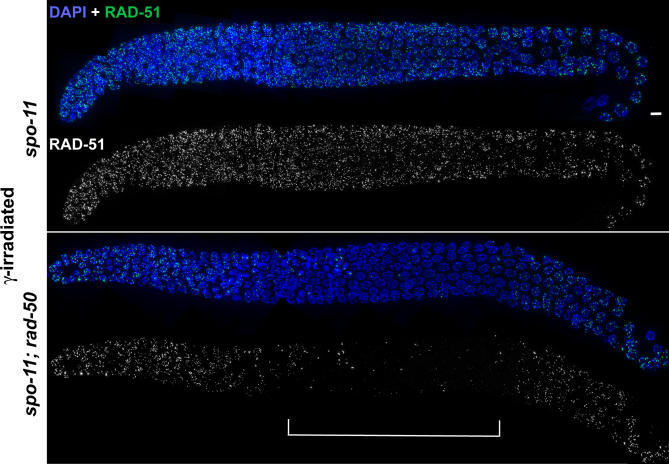
Context-Specific Requirement for Rapid Accumulation of RAD-51 at Sites of IR-Induced BreaksGerm lines from spo-11(ok79) and spo-11(ok79); rad-50 hermaphrodites fixed 1 h after exposure to 1 krad γ-irradiation and stained with DAPI and RAD-51 antibody. RAD-51 foci are detected in germ cell nuclei throughout the spo-11 gonad, from the proliferating nuclei at the distal tip (left) through nuclei at the diplotene stage of meiotic prophase (right). In the spo-11; rad-50 mutant, in contrast, RAD51 foci are absent in most nuclei in the central portion of the gonad, indicated by the bracket, from the onset of meiotic prophase through the mid-pachytene/late pachytene transition (see Figure 4). Scale bar = 5 μm.